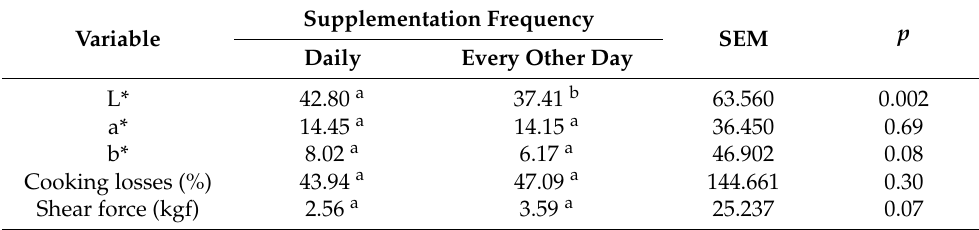
Table 7. Meat quality of sheep submitted to intermittent supplementation on Masai grass pasture.